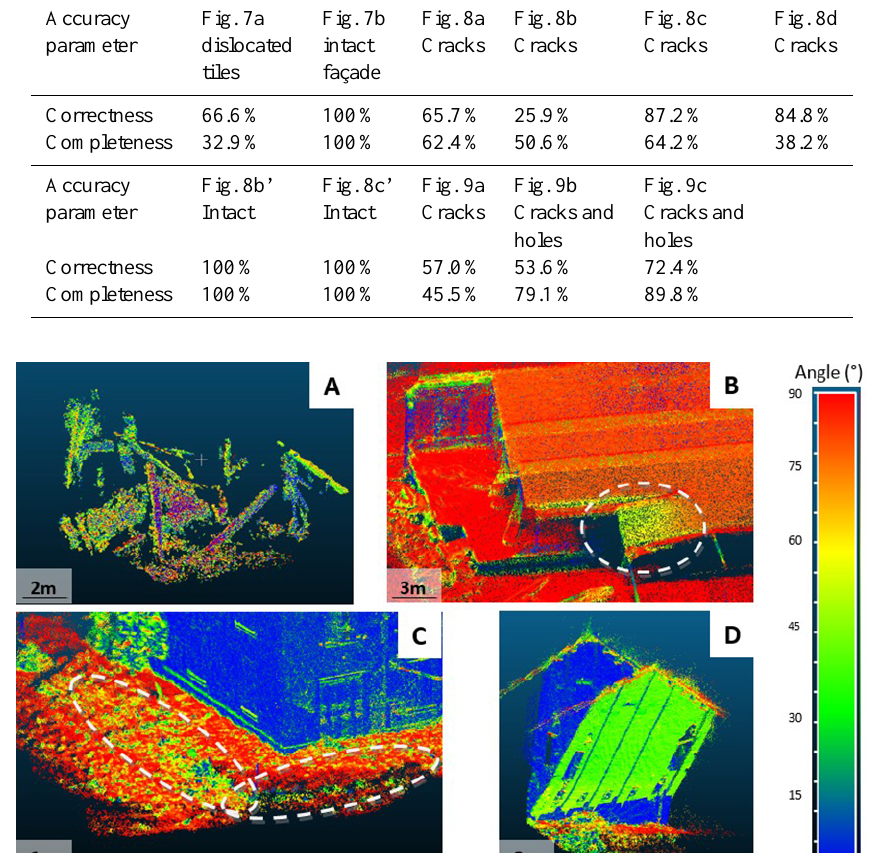
Table 2. Results of the accuracy assessment.